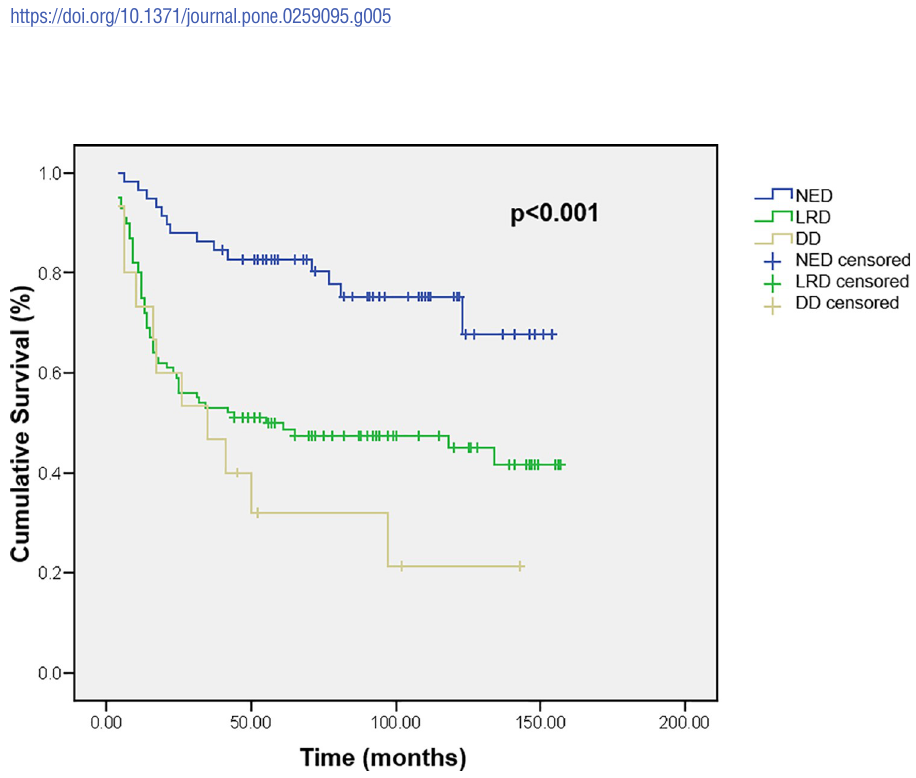
Fig 6. Cumulative survival of children with brain tumors according to extent of the disease. NED–no evidence disease, LRD–local residual disease, DD–disseminated disease.